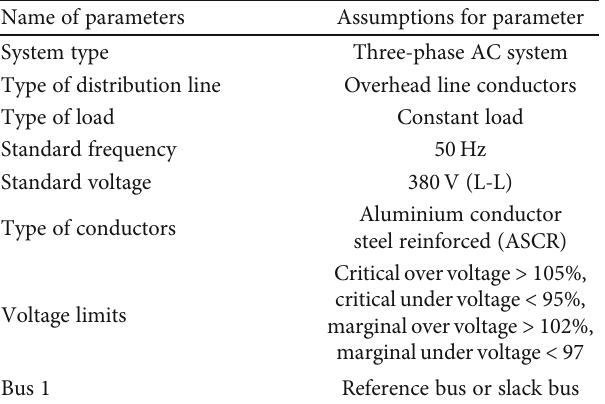
Table 1: Speci fi cations of the existing